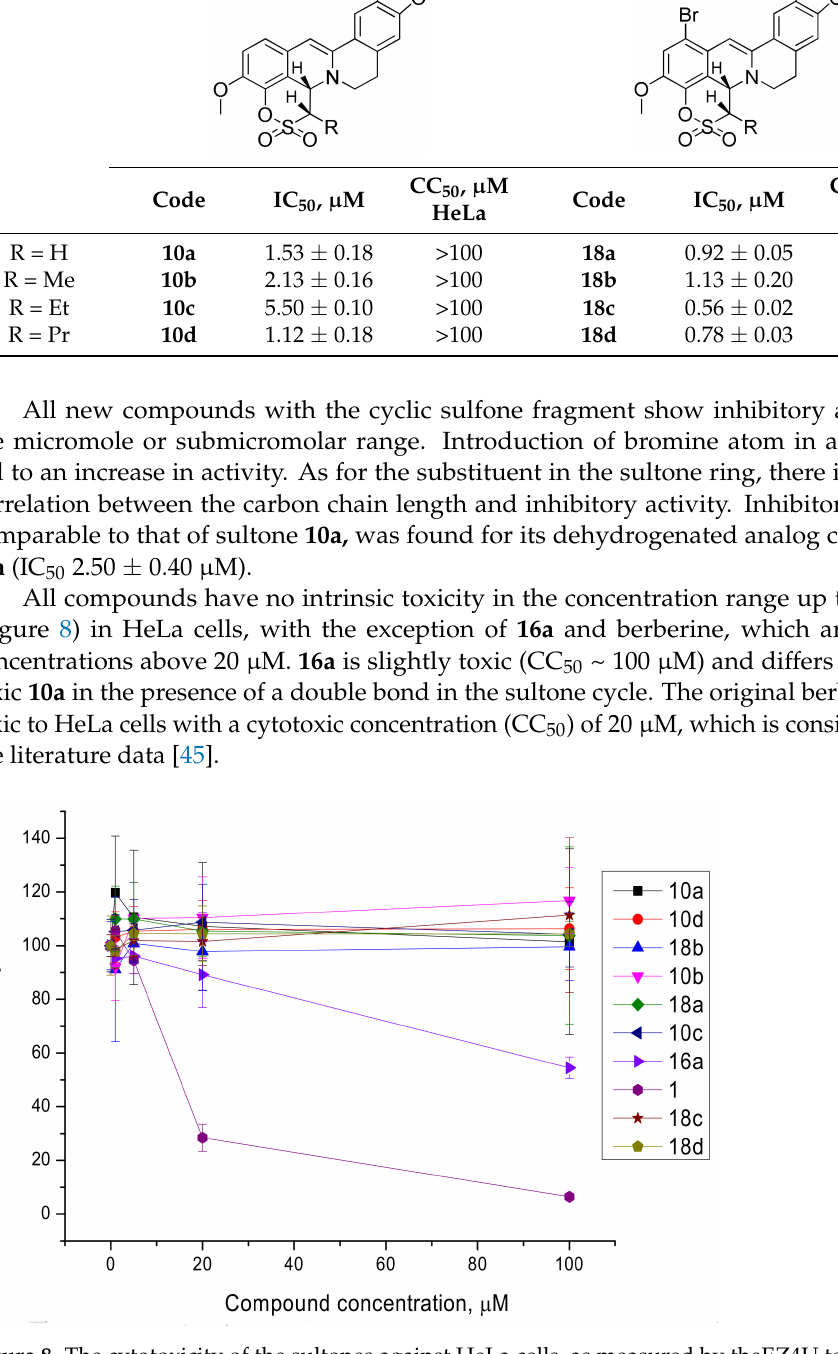
Figure 8. The cytotoxicity of the sultones against HeLa cells, as measured by theEZ4U